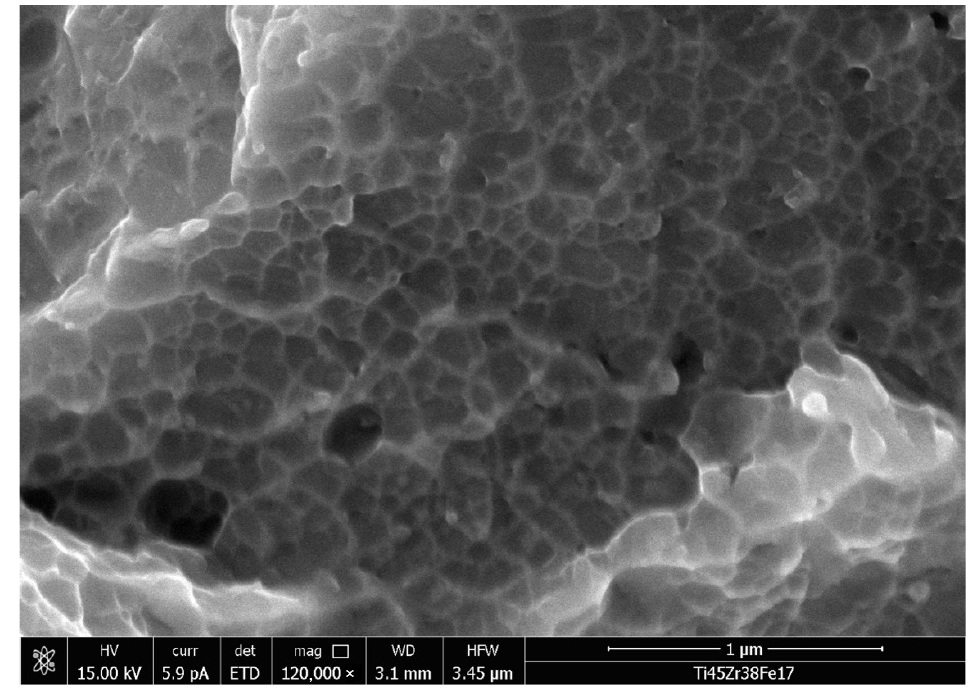
Figure 1. The SEM images of the amorphous Ti 45 Zr 38 Fe 17 . The phase changes for the amorphous Ti 45 Zr 38 Fe 17 during the heating in the temper- ature range from 200 °C to 800 °C recorded with the DSC are shown in Figure 2.